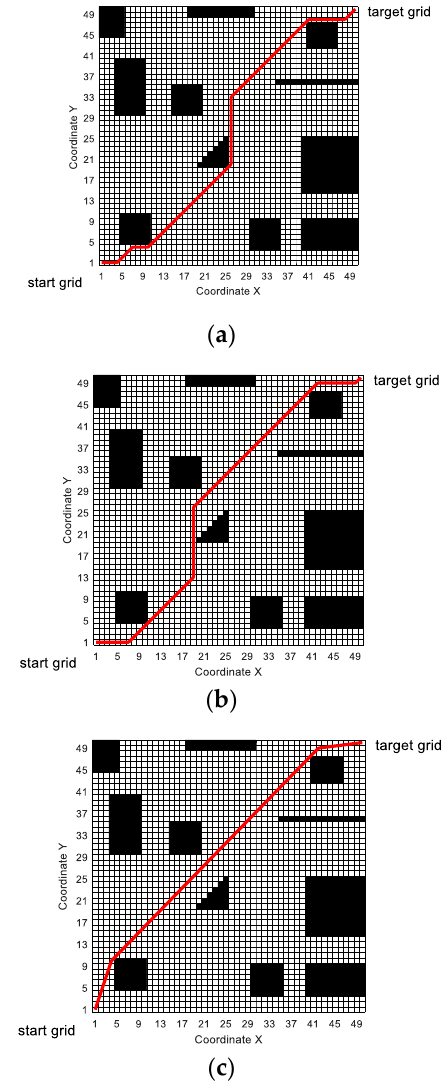
Figure 19. Simulated paths of the three algorithms. ( a ) SGA; ( b ) PCDA; ( c ) MPMGA.